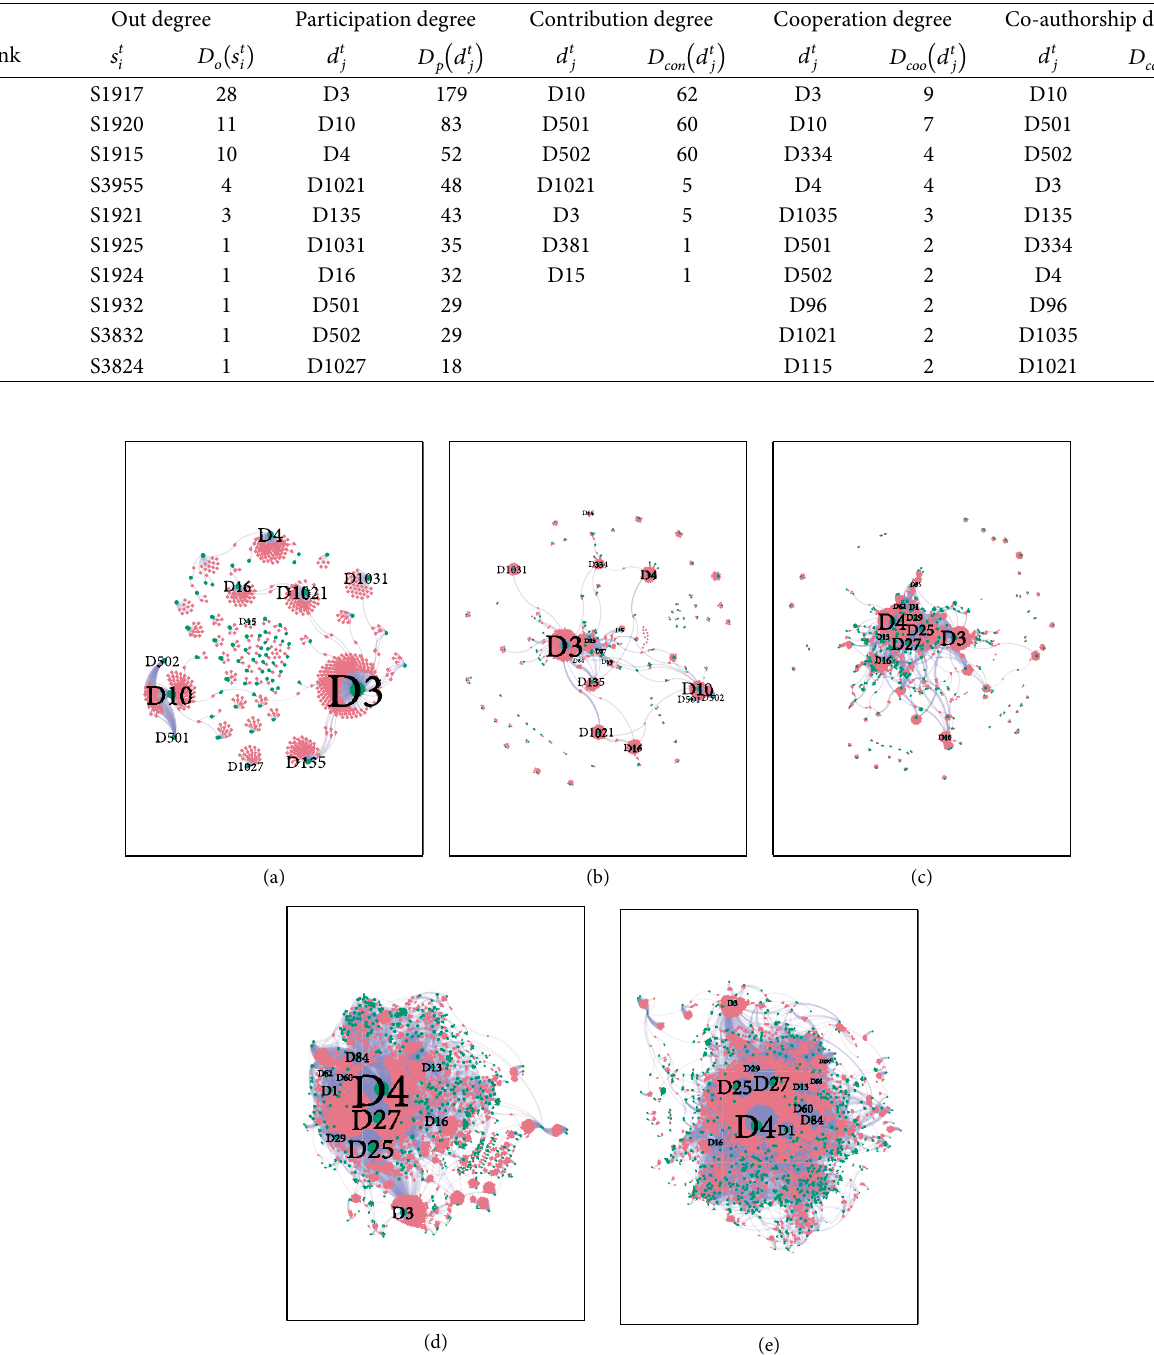
Table 1: The top ten standards and drafters in high indicators till 1997.